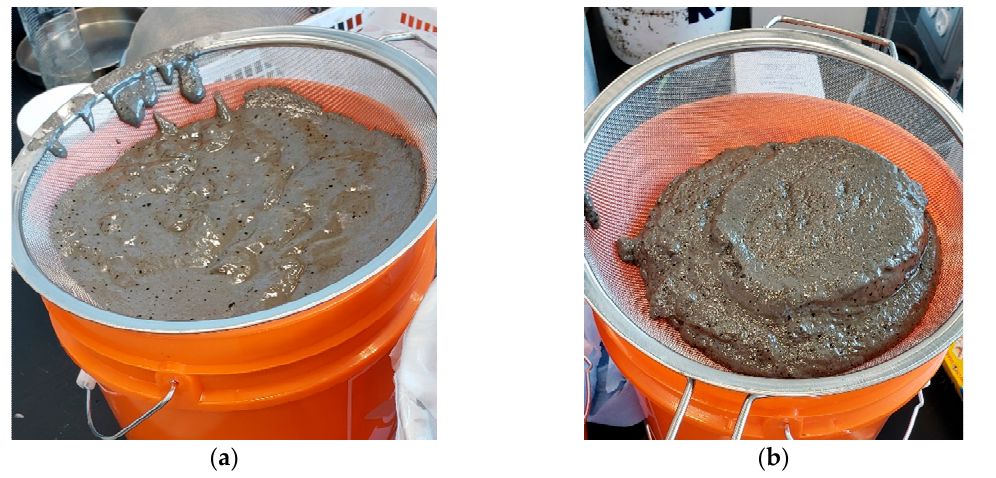
Figure 13. Flocculated FFT-1 by polymer NRG1000 at the same polymer dosage: ( a ) polymer solution injection rate at 84 mL/s; ( b ) polymer solution injection rate at 33 mL/s.